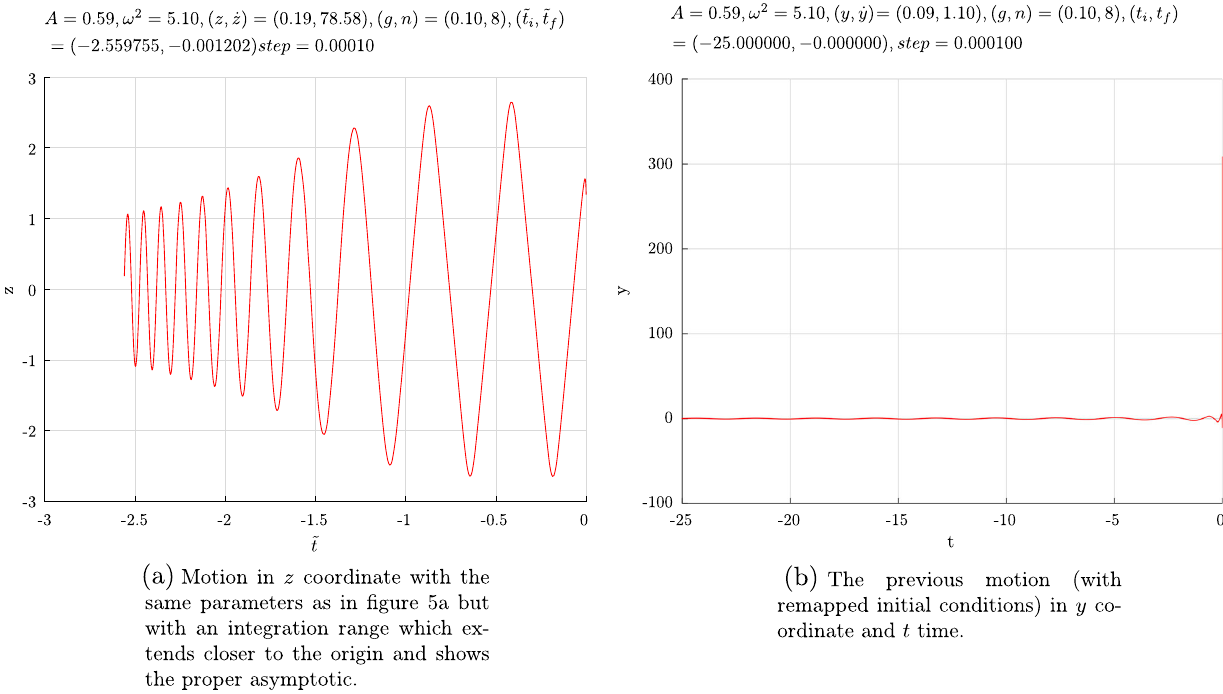
Fig. 6 Classical motion with α < 0 with a proper integration range to show the expected